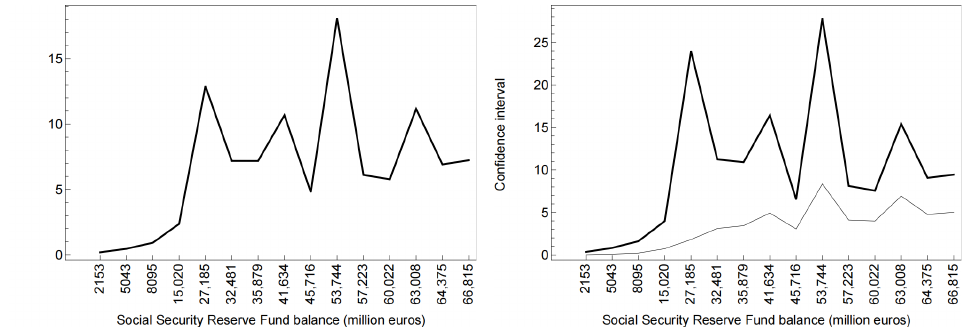
Figure 6. ( left ); Expected time to unsustainability; ( right ) The thick line represents the exact value and the thin one, the estimated value and the corresponding 95% confidence interval. The thick line represents the upper bound of the interval and the thin line, the lower bound. Source: Devised by the